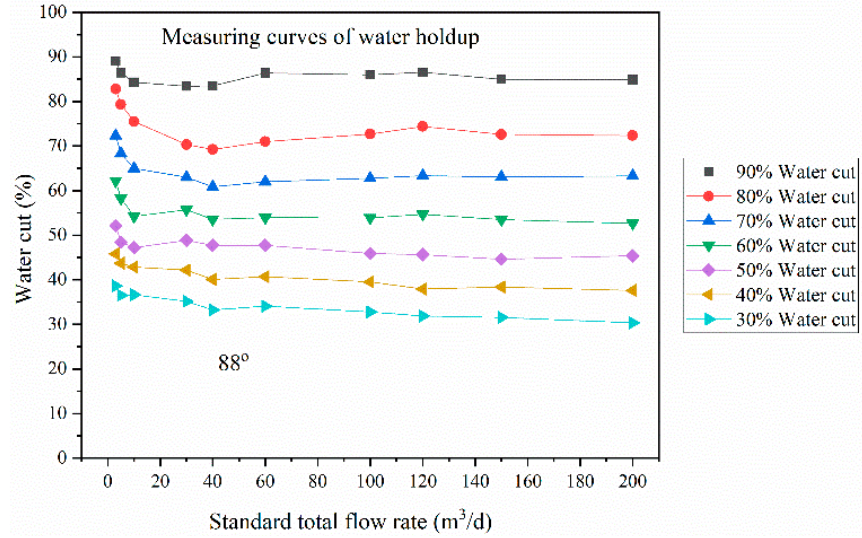
Figure 8. Water holdup measurement chart (inclination angle 88°).